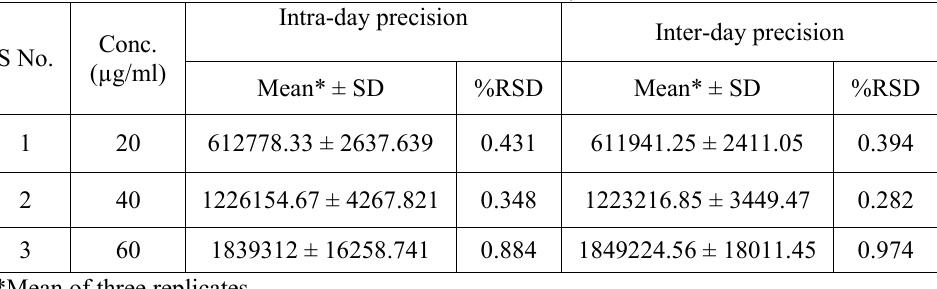
Table 2. Precision Study.